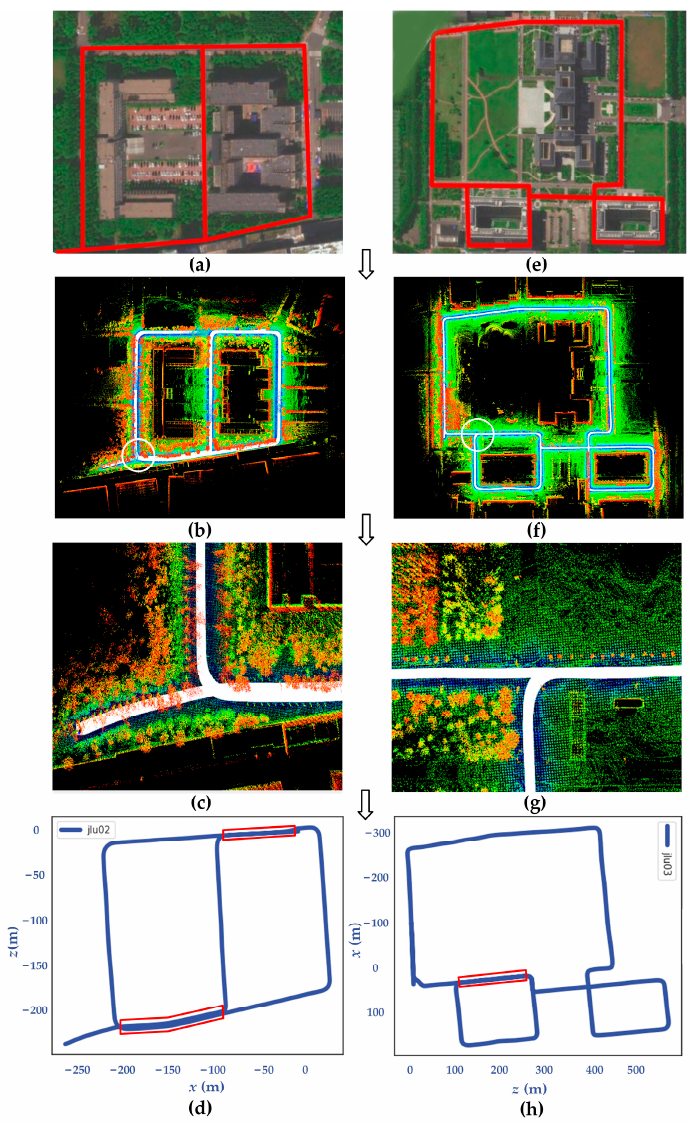
Figure 8. Mapping and LCD results should be listed as the ( a – f ) mapping and LCD results on KITTI- 00, KITTI-02, and KITTI-05; ( g , h ) mapping and LCD results on jlu00. The red and yellow lines indi- cate the detected obverse and reverse loop closures, respectively.